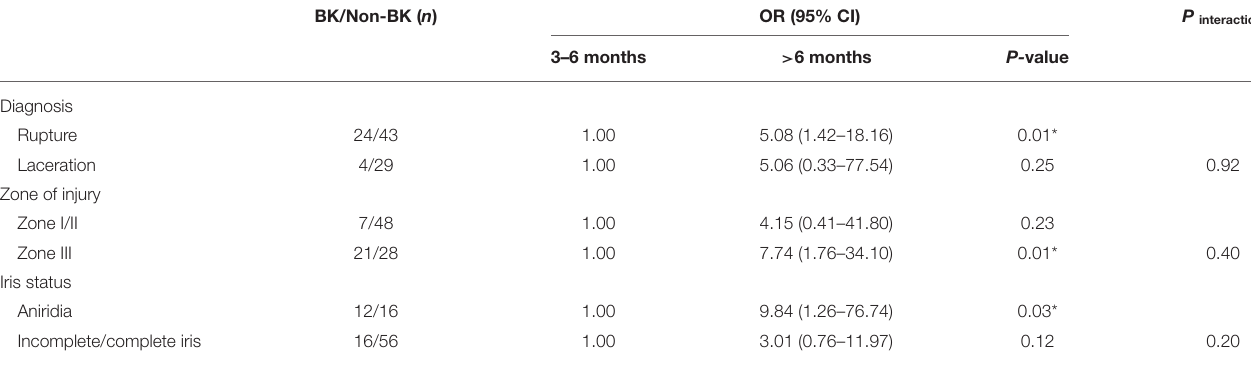
TABLE 3 | Association between the time of silicone oil retention and band keratopathy stratified by diagnosis, injury zone, and iris status.